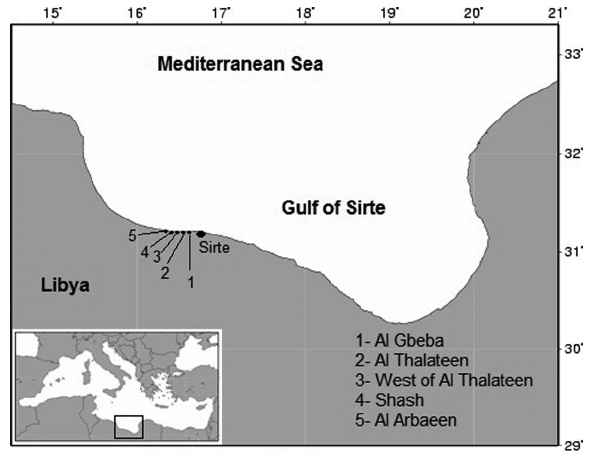
Fig . 1. – The loggerhead nesting sites on Sirte beaches